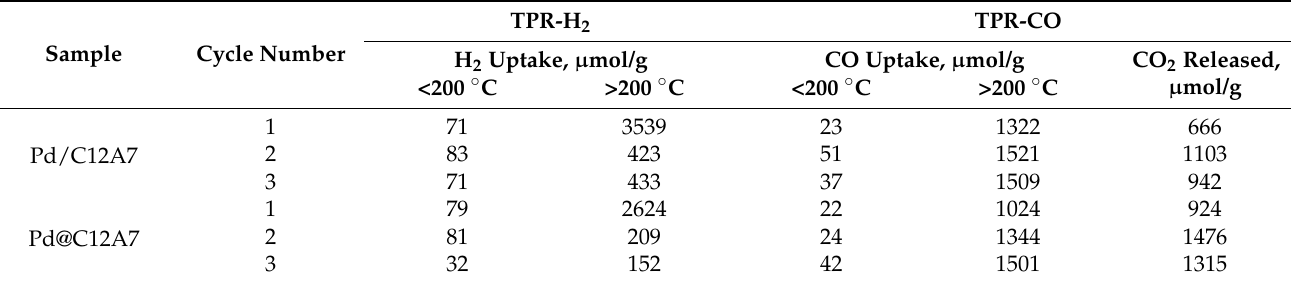
Table 3. Quantitative data for TPR-H 2 and TPR-CO